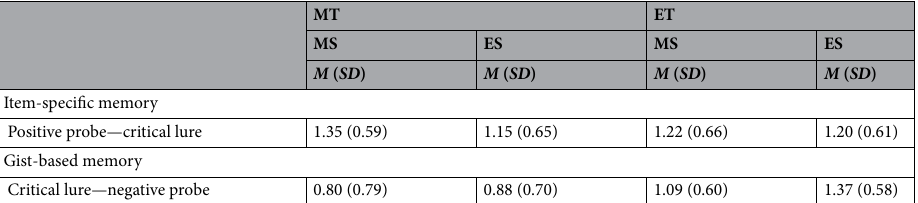
Table 3. Measures of sensitivity (d ′ ) of phonologically similar pseudowords for morning- and evening-types at different time-of-day (morning and evening) calculated for item-specific memory and memory for gist. MT morning type, ET evening type, MS morning session, ES evening session, M mean, SD standard